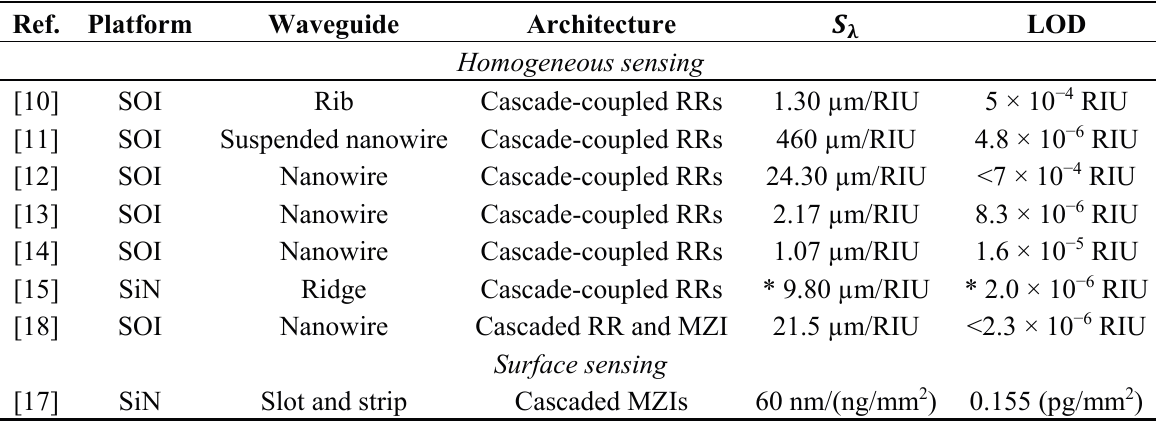
Table 1. Fabricated silicon Vernier RI sensors operating in the near-infrared, around λ = 1.55